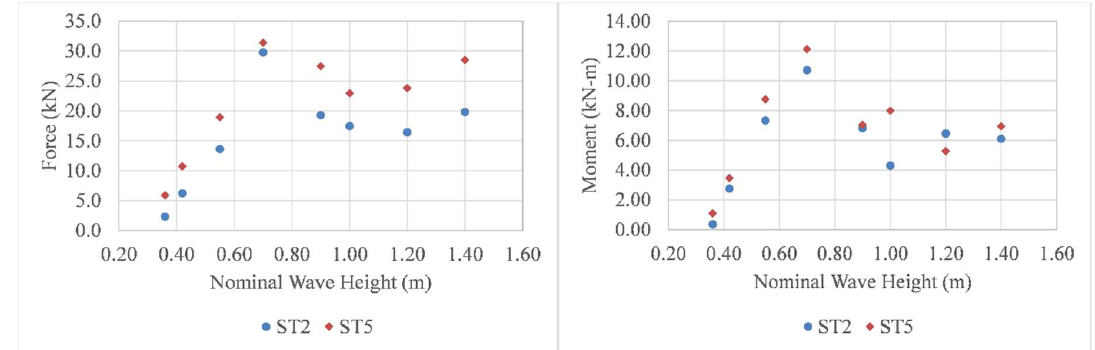
Figure 10. Max recorded uplift forces ( left ) and overturning moments ( right ), for the two deck types and all the heights tested at d = 2.0 m.